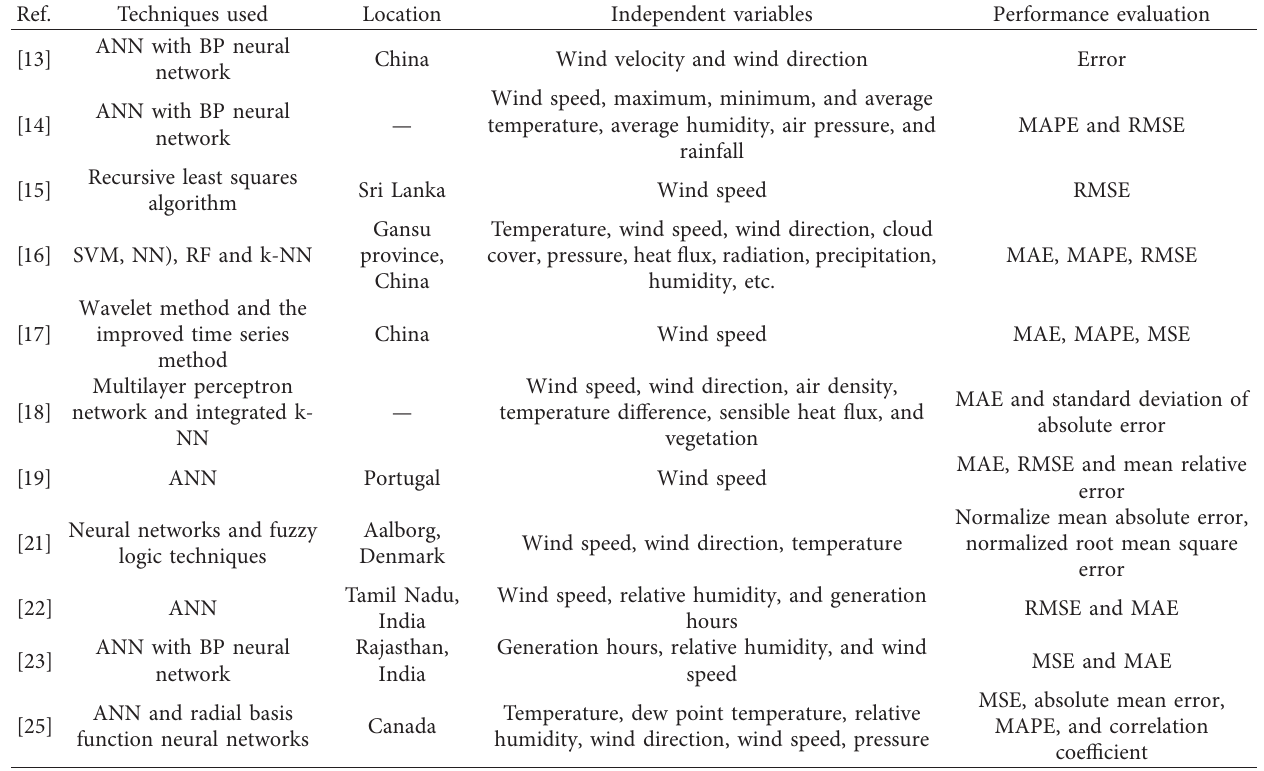
Table 2: Comparison of similar research